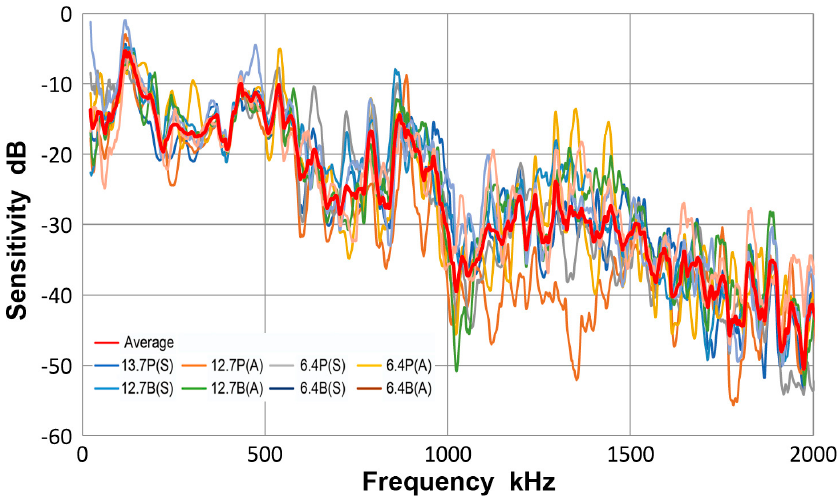
Figure 11. Receiving sensitivity of PAC Pico sensor. Average of eight curves-red, thick plate 12.7P(S)-blue, thick plate 12.7P(A)-orange, thin plate 6.4P(S)-grey, thin plate 6.4P(A)-yellow, thick bar 12.7B(S)-light blue, thick bar 12.7B(A)-green, thin bar 6.4B(S)-dark blue, thin bar 6.4B(A)-brown. Tests